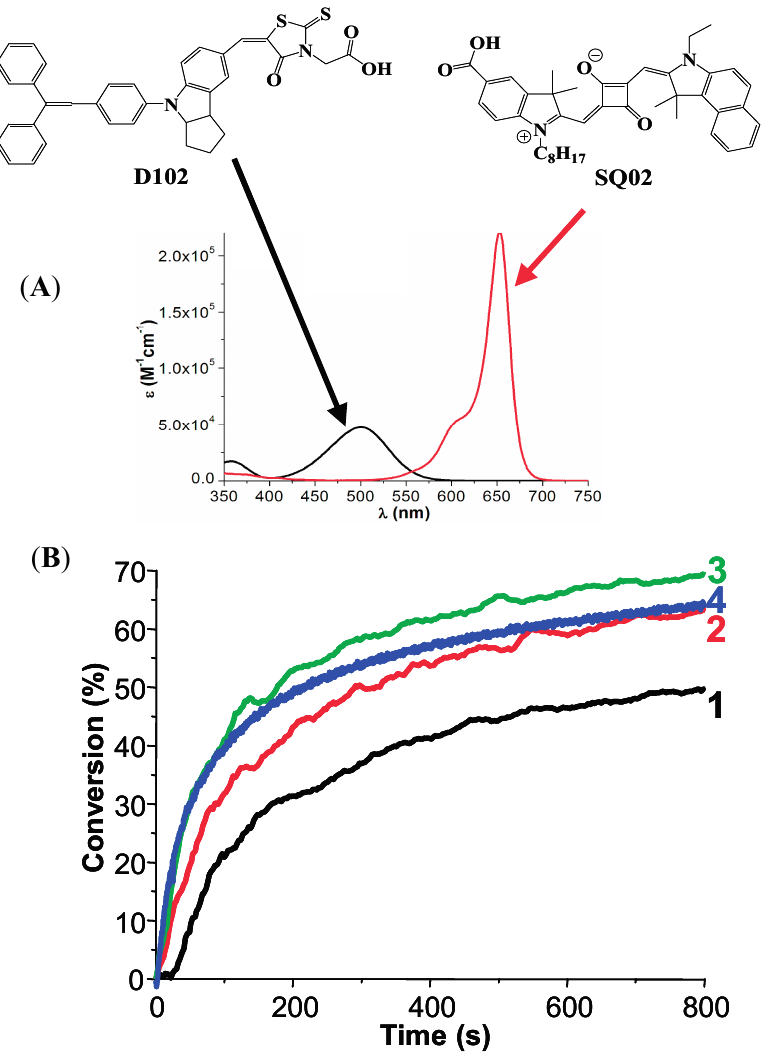
Figure 5. Panchromatic photopolymerizable cationic films using indoline and squaraine dye based photoinitiating systems [116]: ( A ) absorption spectra for the dyes